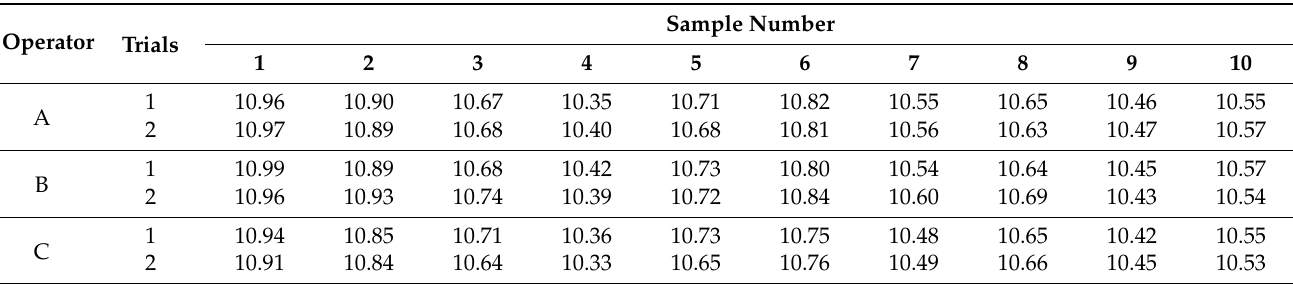
Table 2. Measured data of nut height (in mm) [20].